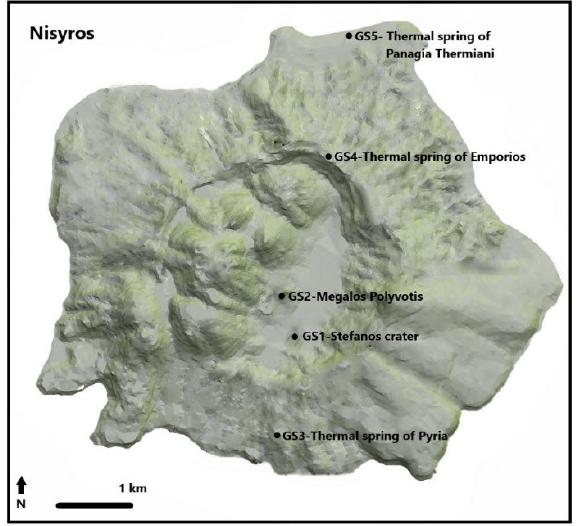
Figure 7. 3D representation of Nisyros Island, indicating the location of the studied geosites [57],